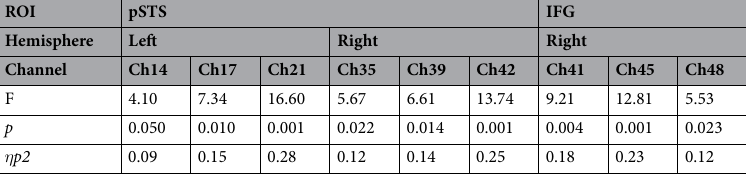
Table 1. Result of significant main effect of Role in the analysis of two-way ANOVA [Role (Yellow vs. Blue) × Condition (Competition vs. Cooperation)]. Note: pSTS, posterior superior temporal sulcus; IFG, inferior frontal